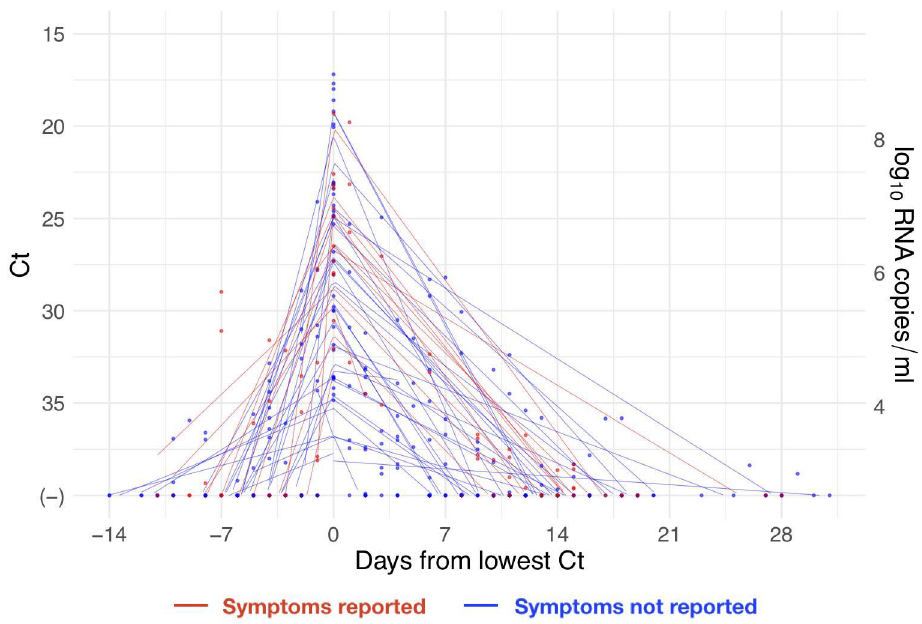
Fig 2. Reported cycle threshold (Ct) values with individual-level piecewise linear fits. Ct values (points) for the 46 acute infections aligned by the date when the minimum Ct was recorded for each individual. Lines depict the best-fit piecewise linear regression lines for each individual with breakpoint at day 0. Red points/lines represent individuals who reported symptoms, and blue points/lines represent individuals who did not report symptoms. Five positive tests were omitted that occurred > 20 days prior to the individual’s minimum Ct value, all of which had Ct > 35. The vertical axis on the right-hand side gives the conversion from Ct values to RNA concentration. Underlying data are available at https://github.com/gradlab/CtTrajectories/tree/main/figure_data/Fig2 [10].